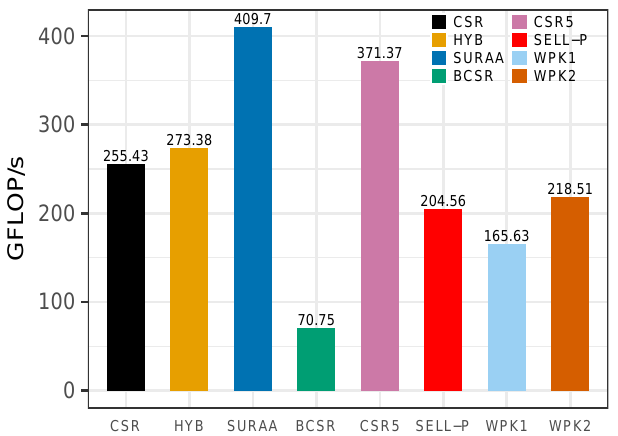
Figure 8. SURAA: comparison of aggregate GFLOP/s of all the eight